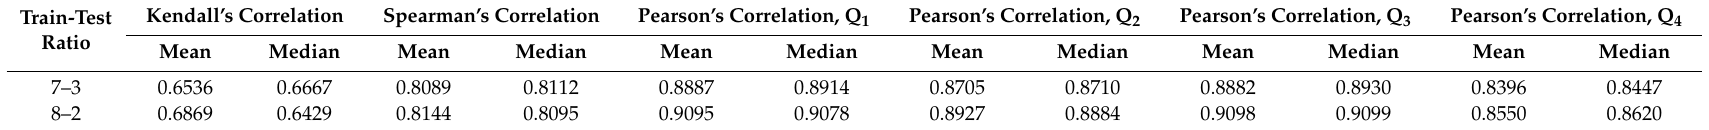
Table 3. Kendall’s, Spearman’s, and Pearson’s correlation for di ff erent train-test dataset ratio—SI V